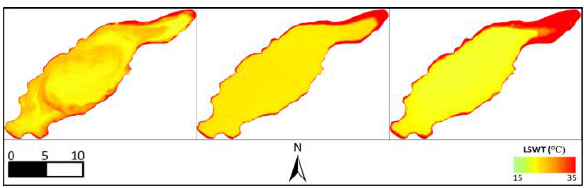
Figure 5 . The Burdur Lake LSWT maps for the years 1998, 2008 and 2018, respectively, from left to right.